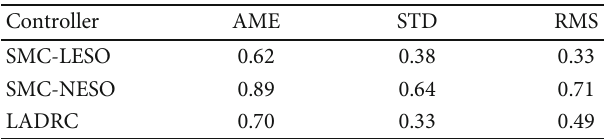
Table 2: RMS, AME, and STD of steady state error for roll angle